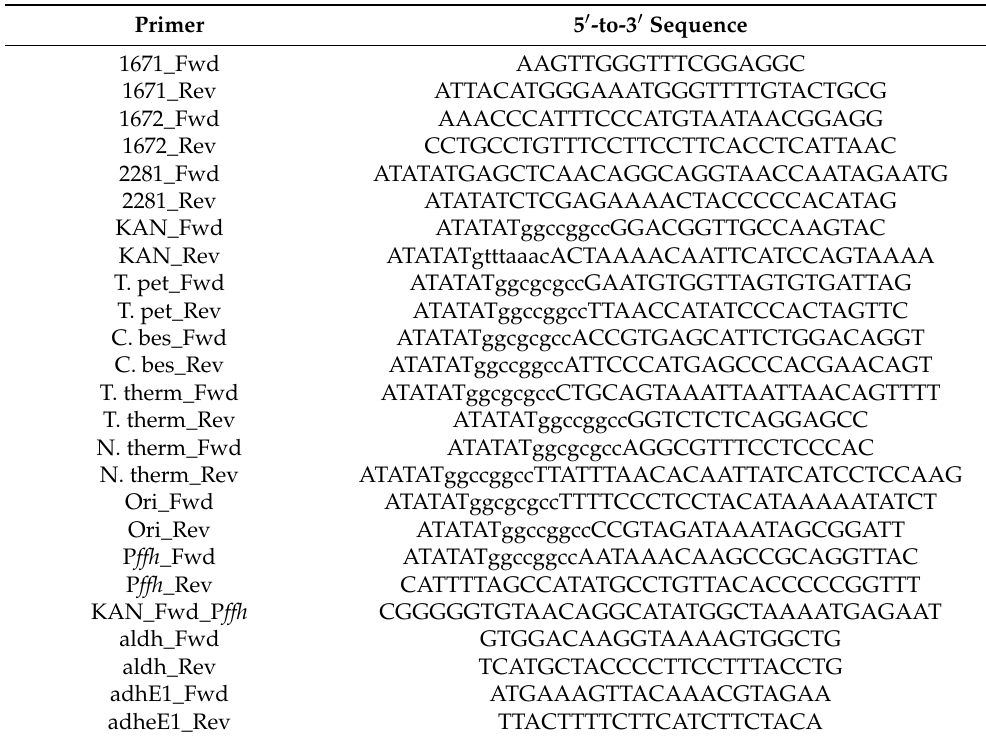
Table 1. List of primers used in this study. Low-case characters represent restriction